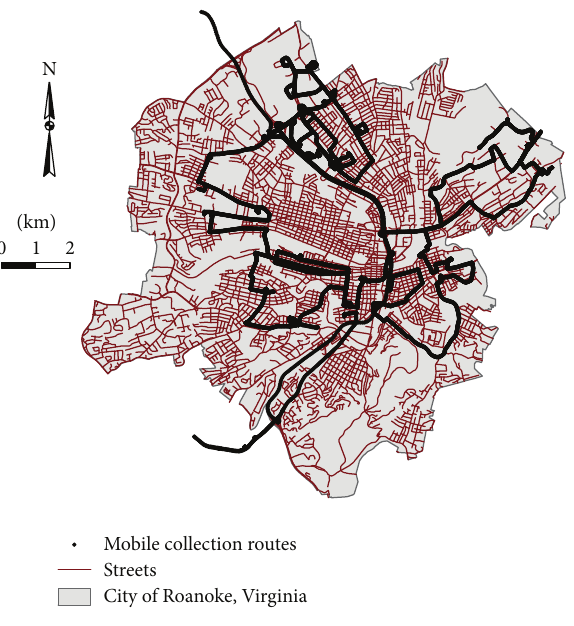
Figure 8: Routes 1, 2, 3, and 4 July